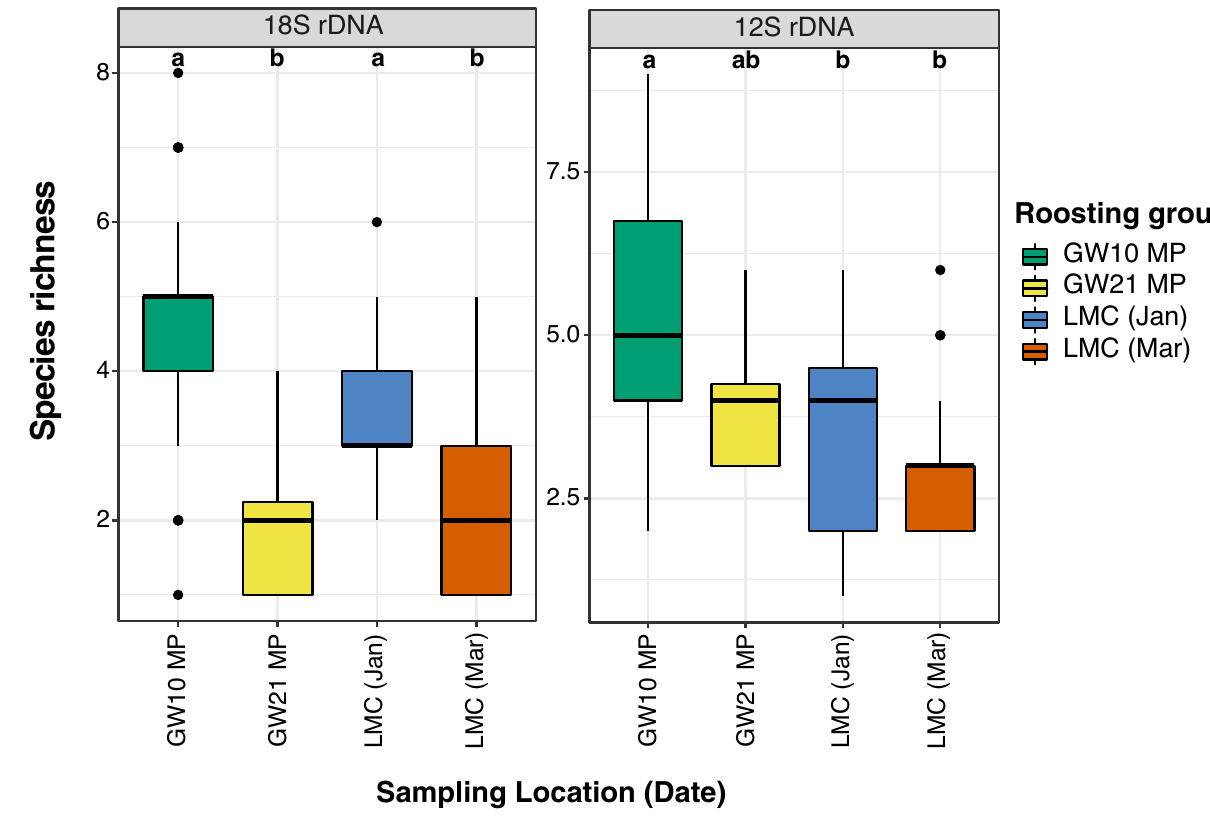
Figure 5. Incidence-based species richness of the dietary taxa in Platalea minor based on the 18S and 12S rDNA dataset (n = 110 and 96 respectively). The box represents the interquartile range. The line inside the box indicates the median. The upper whiskers extend to the highest value within 1.5 × the interquartile range, and the lower whiskers extend to the lowest value within 1.5 × the interquartile range. Black dots are outliers. Letters at the top of the boxes indicate significantly different groups. See Fig. 3 for abbreviations. The abundance-based figures and related tables are available in the Supplementary Fig. S1 and Table